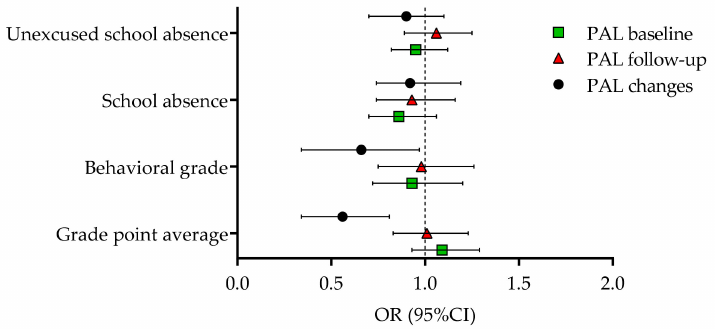
Figure 2. Logistic regression results for the dichotomized criteria: PAL at the baseline, PAL at follow-up (during lockdown), and PAL changes between the baseline and follow-up. Table 2. Descriptive statistics (F—frequencies; %—percentages) for the study variables, with the differences between the groups according to the insufficiency/sufficiency of their physical activity levels (PAL) at the follow-up (MW—Mann–Whitney test; χ 2—Chi square test). Insufficient PAL Sufficient